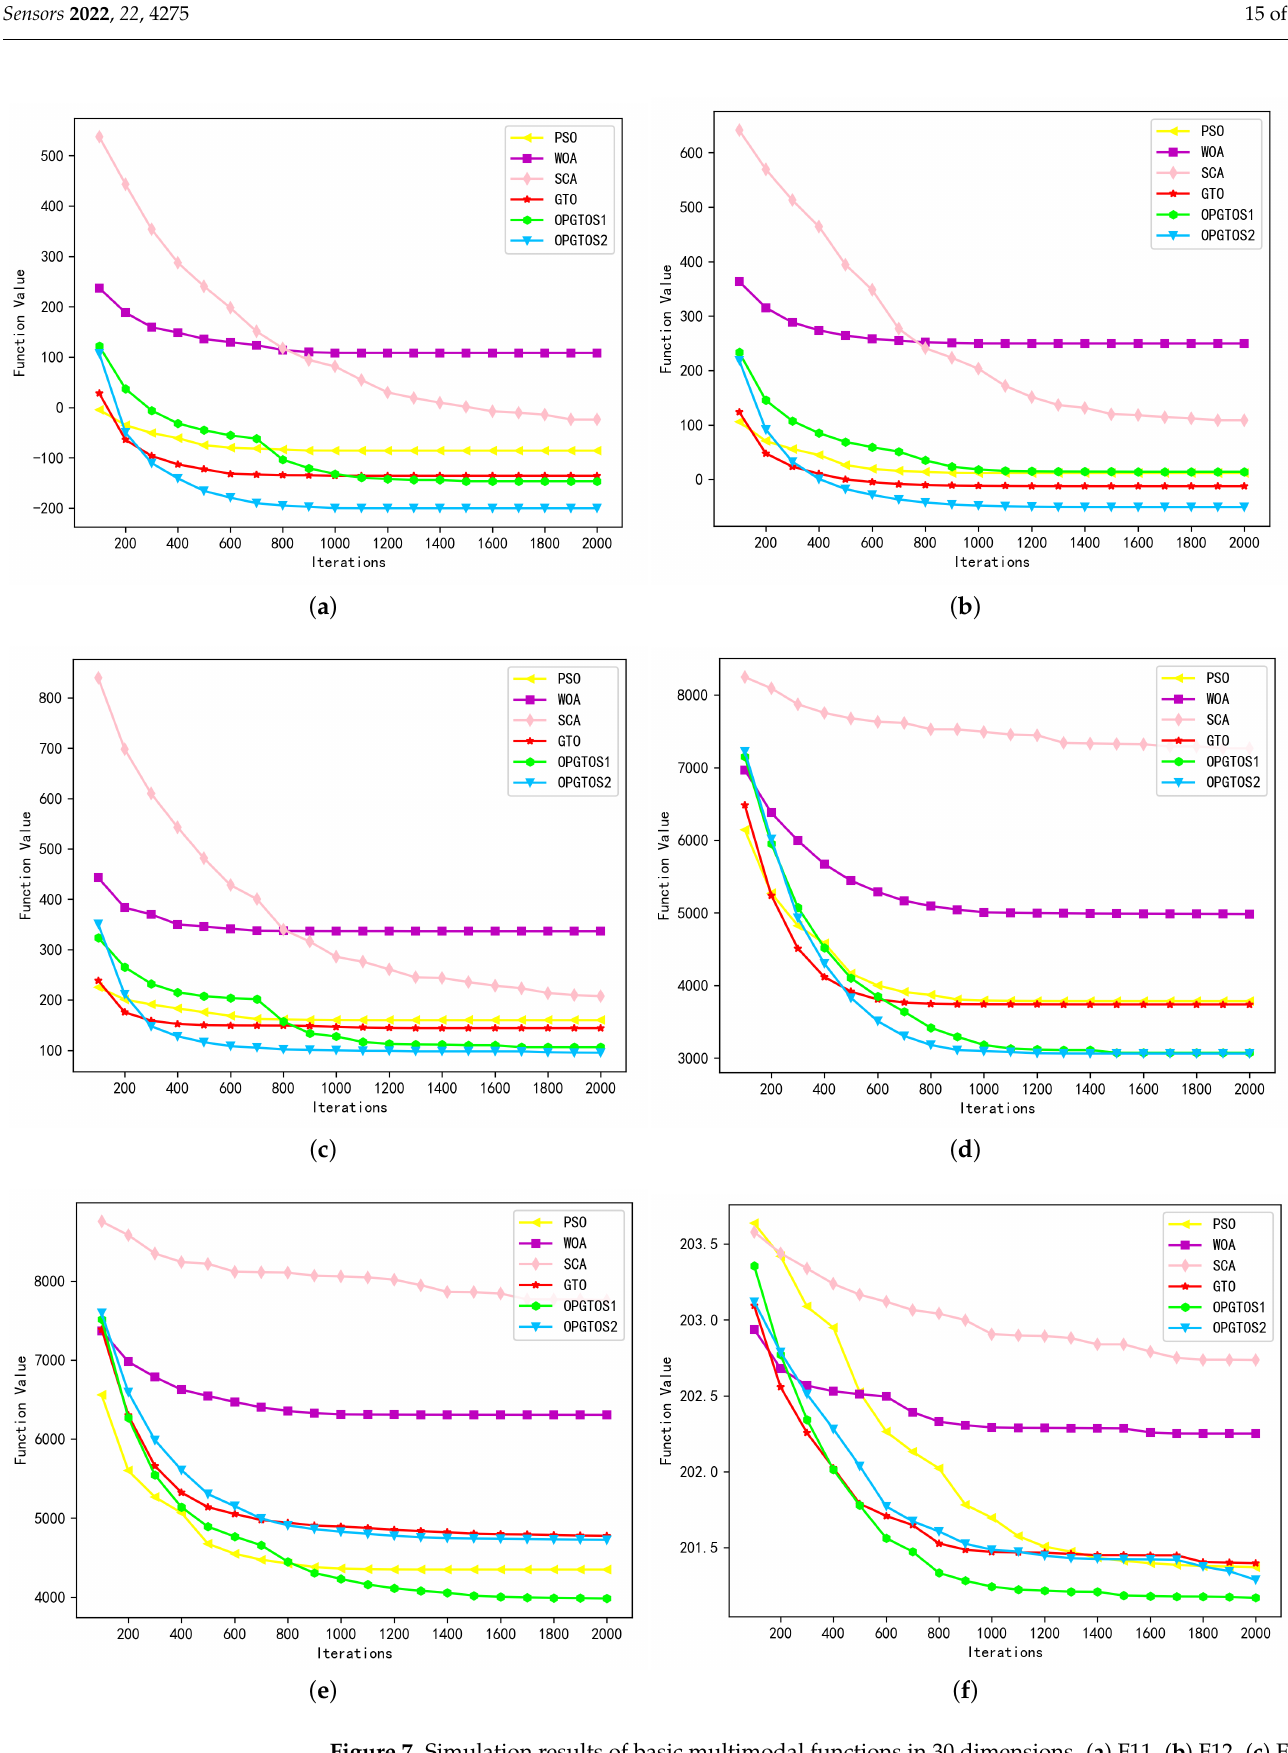
Figure 7. Simulation results of basic multimodal functions in 30 dimensions. ( a ) F11. ( b ) F12. ( c ) F13. ( d ) F14. ( e ) F15. ( f )